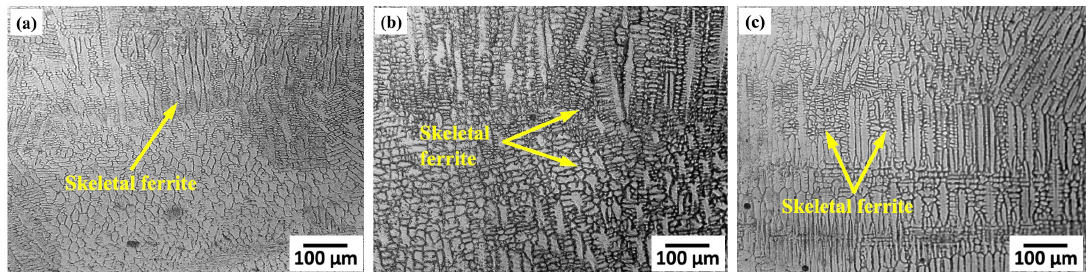
Figure 7. (a) Cellular microstructure at different regions in weldment of 600A, 0.3s, no Ni conditions (b) Cellular structure at higher magnification.